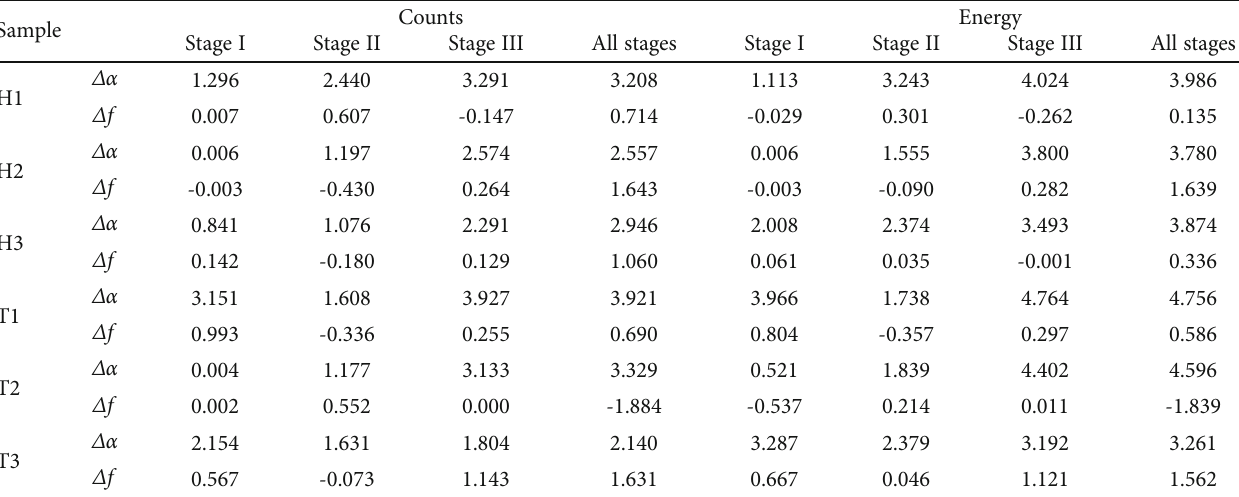
Table 3: Values of Δα and Δ f for di ff erent samples at di ff erent